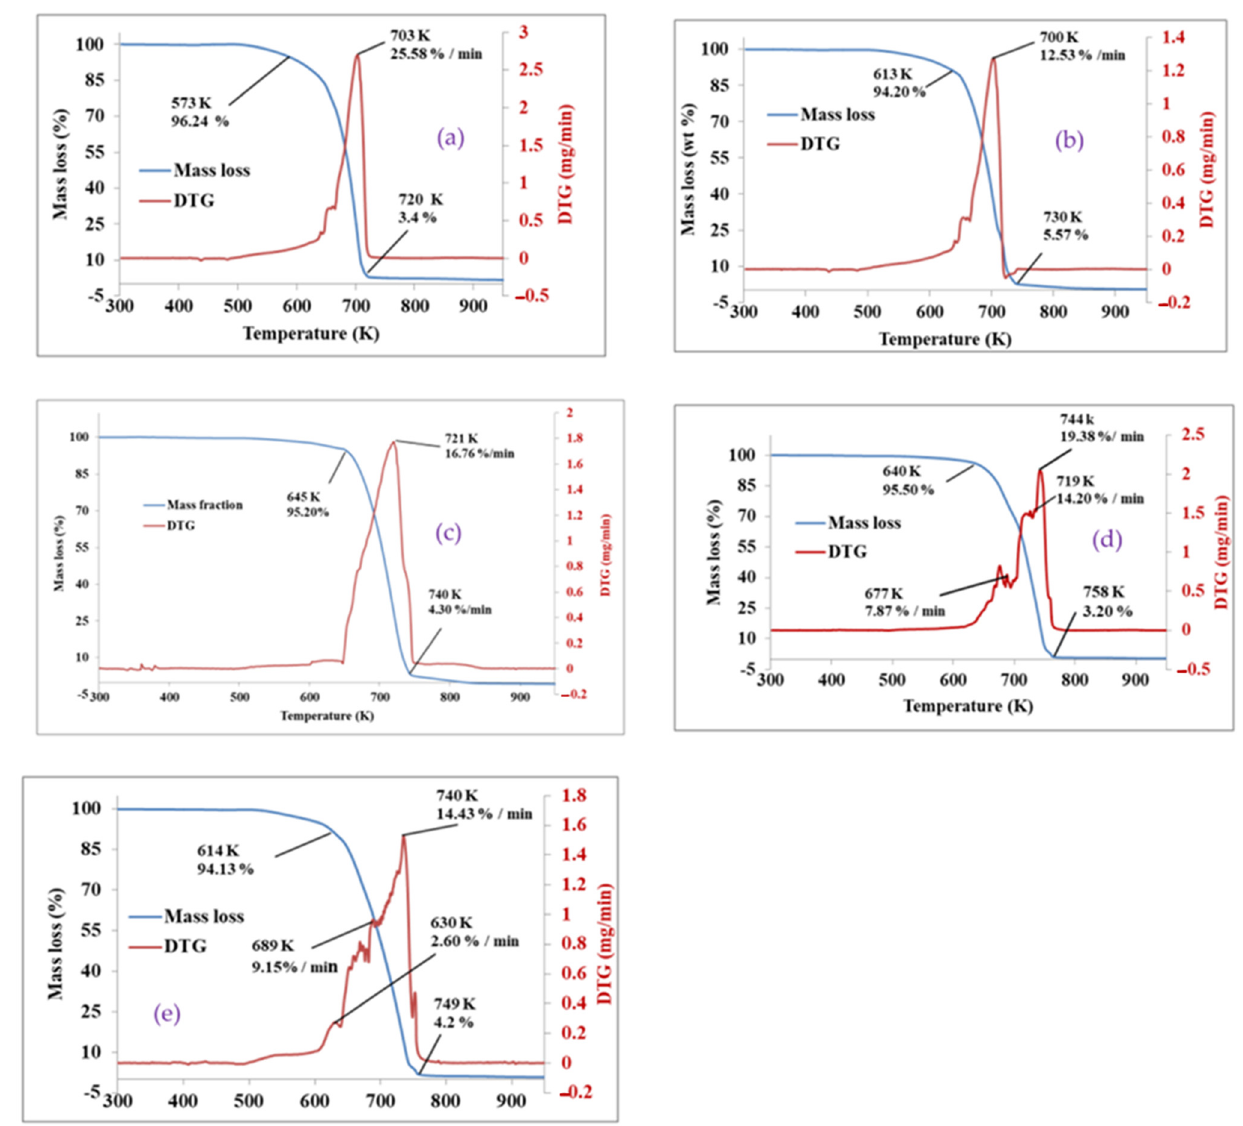
Figure 2. Thermogravimetric (TG) and differential thermogravimetric (DTG) analysis of ( a ) LDPE ( b ) HDPE ( c ) PP ( d ) Mixed virgin plastic ( e ) Domestic plastic